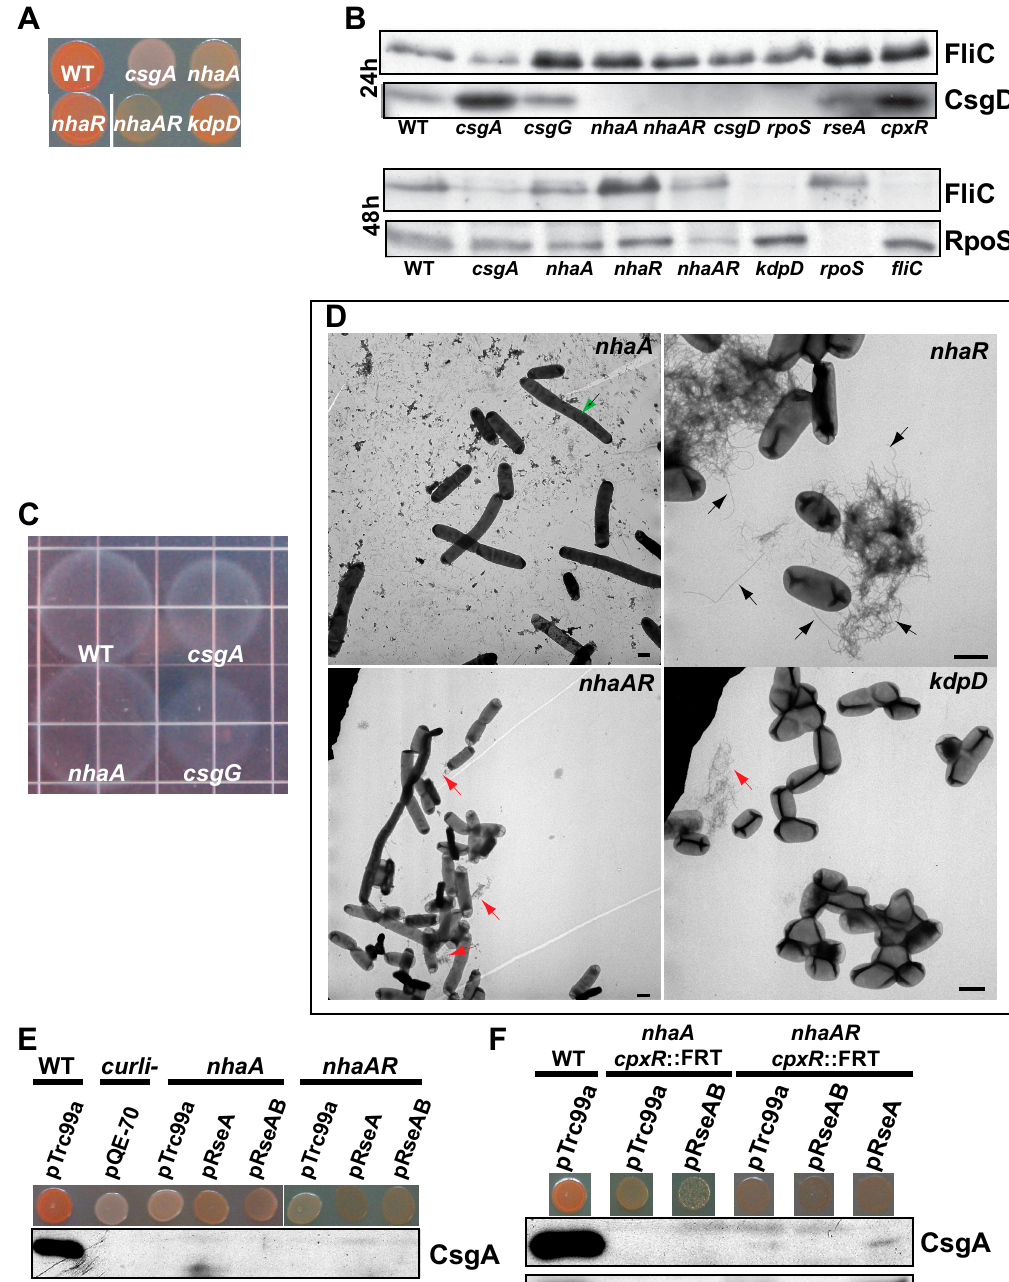
Figure 5. Sodium antiporter gene nhaA is required for curli production. ( A ) Strains were grown on CR indicator plates at 26 °C for two days. ( B ) Whole cell Western blots probed with antibodies to CsgA, CsgG, and FliC at 24 and 48 h. All samples were treated with HFIP; ( C ) Motility of WT, csgA , csgG , and nhaA strains in 0.2% YESCA motility plates at 26 °C. ( D ) TEM images from cells grown for 26 °C for two days on YESCA plates. Black arrows indicate flagella. Red arrows indicate curli. Green arrows indicate filamentous cells. Scale bar equals 1 µm. ( E ) Expression of rseA in trans using pRseA or pRseAB does not rescue curli expression in nhaA or nhaAR strains as detected by CR binding or Western blot probed with antibodies to CsgA or CsgG. ( F ) Expression of rseA in trans from pRseA or pRseAB does not rescue curli production in nhaA cpxR or nhaAR cpxR double deletions as detected by CR binding or Western blot probed with antibodies to CsgA or CsgG.